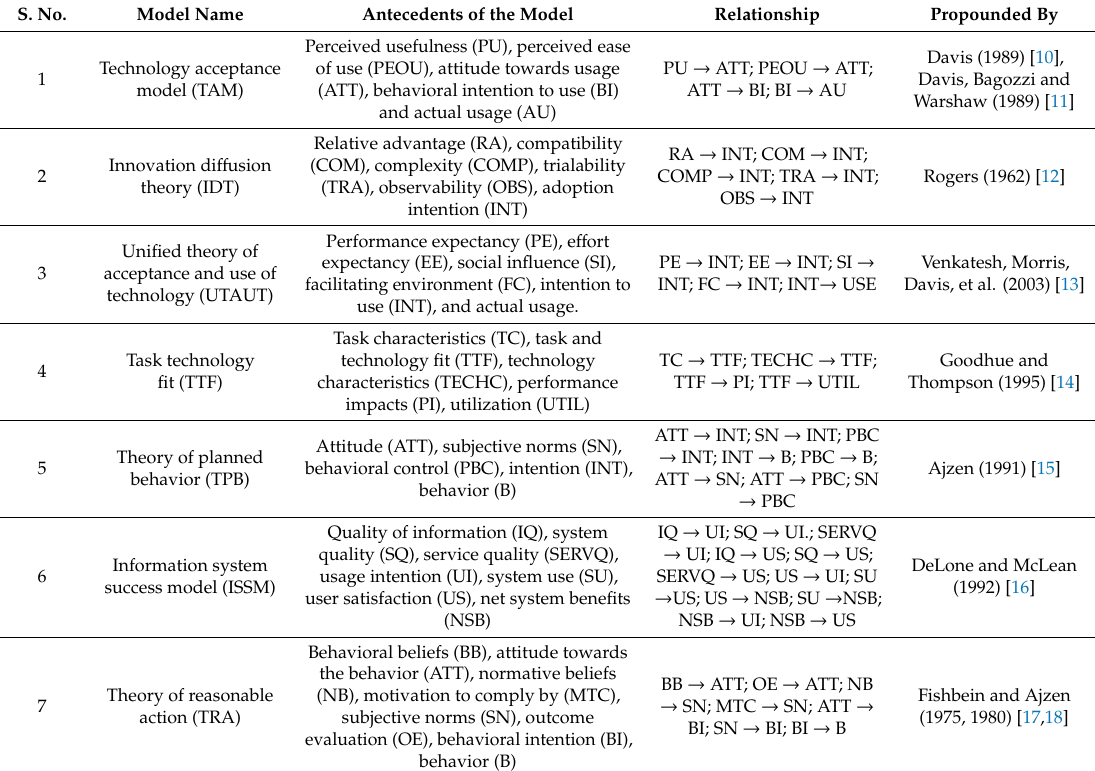
Table 1. Theoretical Models for Technology Adoption